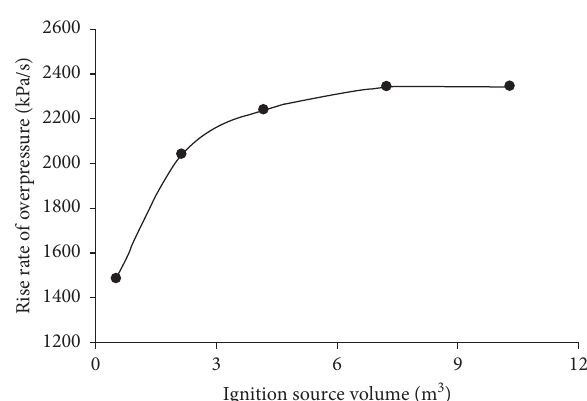
Figure 7: Relationship of rise rate of the overpressure with the ignition source.